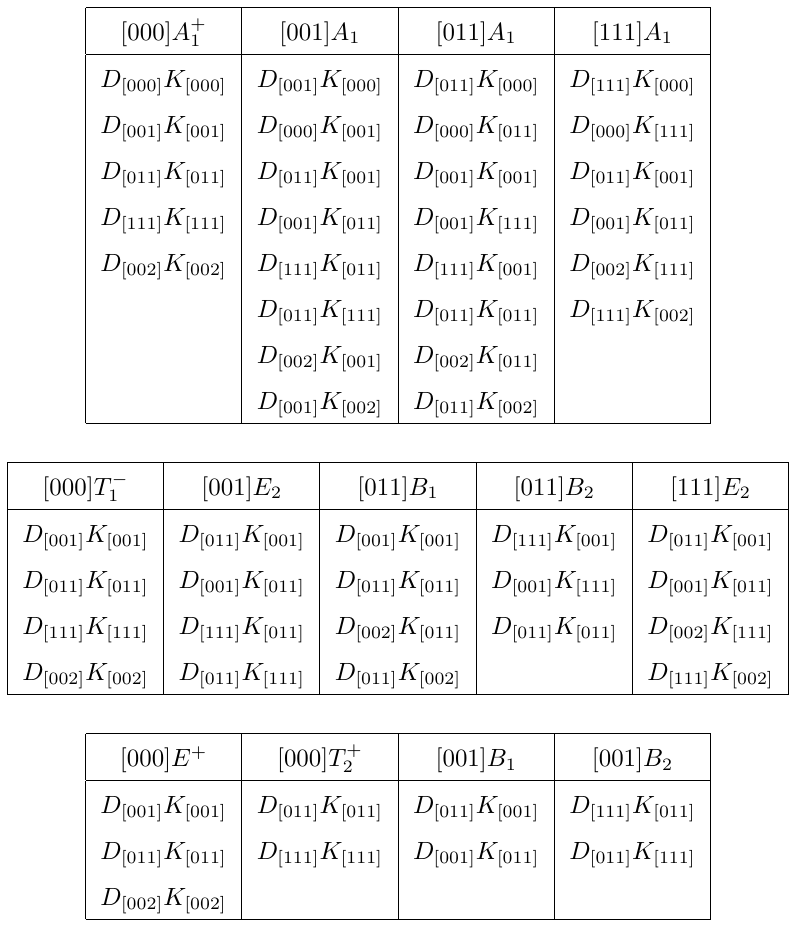
Table 9 . As table 6 but for D ¯ K I = 0 , 1 on the m π = 391 MeV